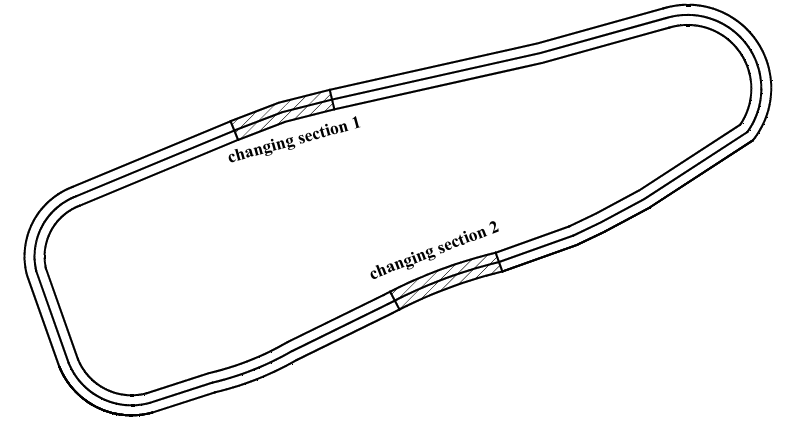
Figure 1. Horizontal alignment of experimental road. Table 6. Radius of changing sections.